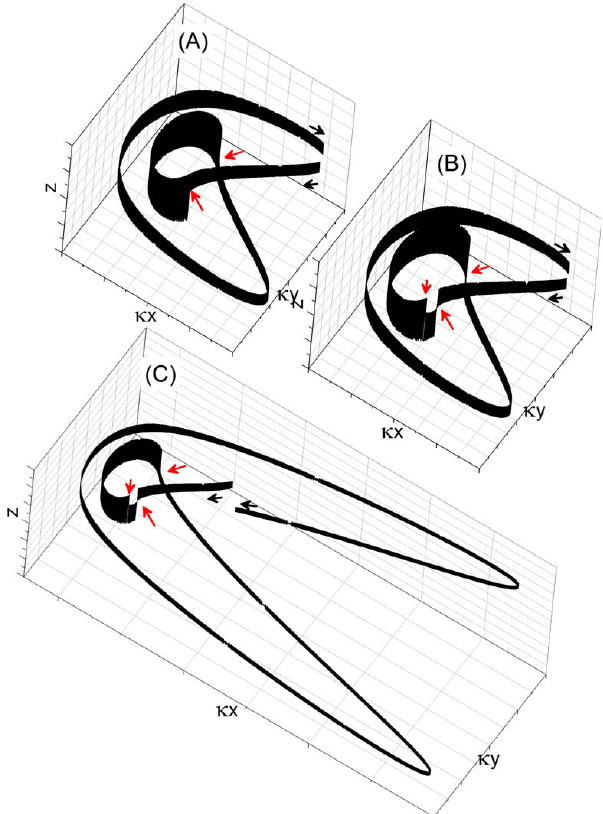
Fig. 11. Three realizations of particle trajectories starting from one point in the plane (κx,p x )